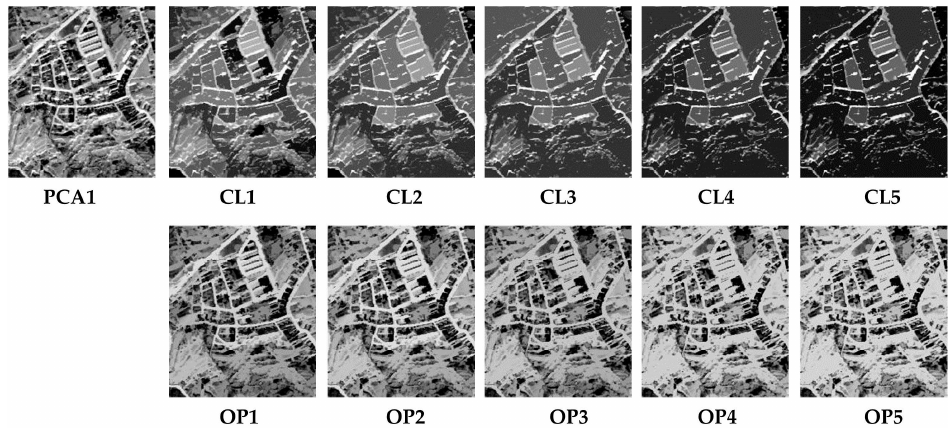
Figure 4. The effect of each filter applied to the original PCA1. Five closing (CL) and five opening (OP) attributes are shown.